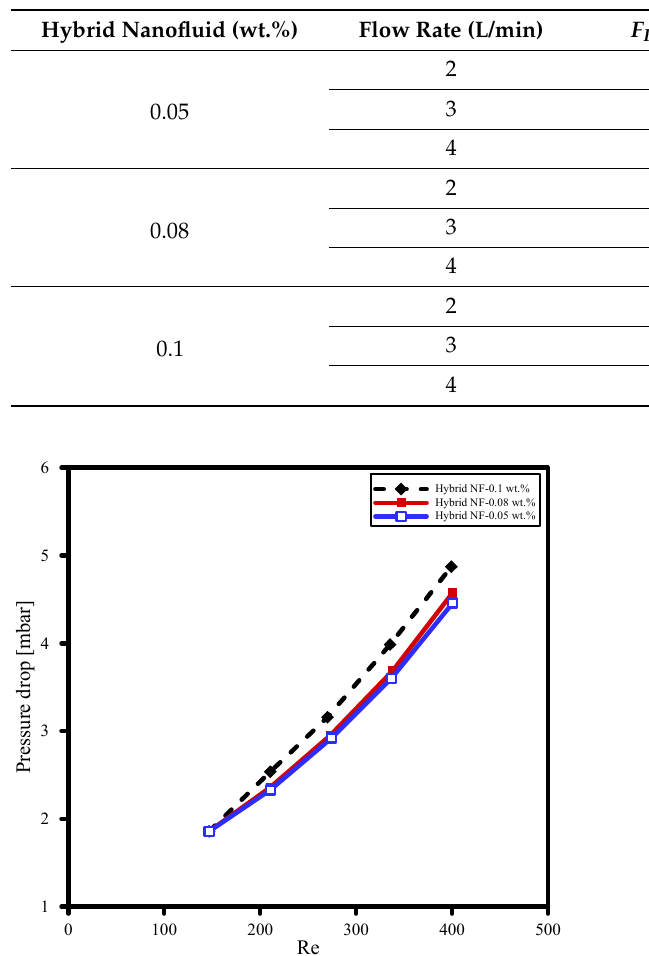
Table 6. Enhancement of removed energy parameter and absorbed energy parameter for hybrid nanofluid, compared with DW.